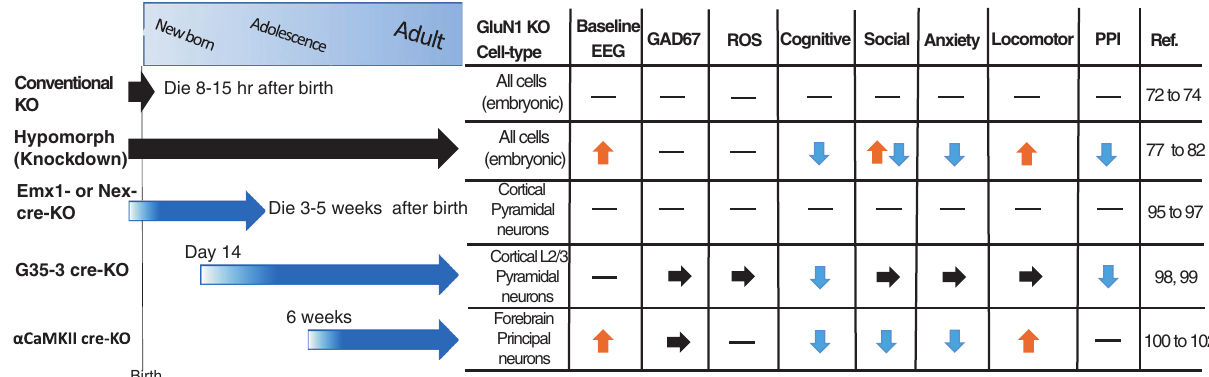
Fig. 1 Summary of schizophrenia-related phenotypes in various GluN1 mutant mice. GluN1 knockdown regardless of cell-types ("hypomorph mouse") presents several aspects of schizophrenia-related signs. GluN1 deletionin glutamatergic neurons (Emx1-cre KO and Nex-cre KO) during development both result in the phenotypes too severe to consider as schizophrenia-related signs. GluN1 deletion in forebrain principal neurons in adulthood (G35-3 cre-KO and α CaMKII cre-KO) appears to be suf fi cient to cause some neuropsychiatric signs, including E/I balance increase and cognitive dysfunction; however, insuf fi cient to induce abnormalities of local GABA neurons seen in schizophrenia pathophysiology. Mouse strains with black arrows (top two strains) received genetic manipulation targeted to all the cells throughout the development. The manipulation in the mouse with blue arrows (bottom three strains) was largely restricted to the particular cell-types of forebrain principal neurons. Thick arrows in the left panel show the period of knockout occurring in the designated KO cell-type in the cortex. Hyphen denotes no data in the right Table. ROS reactive oxygen species. PPI , prepulse inhibition of startle re fl